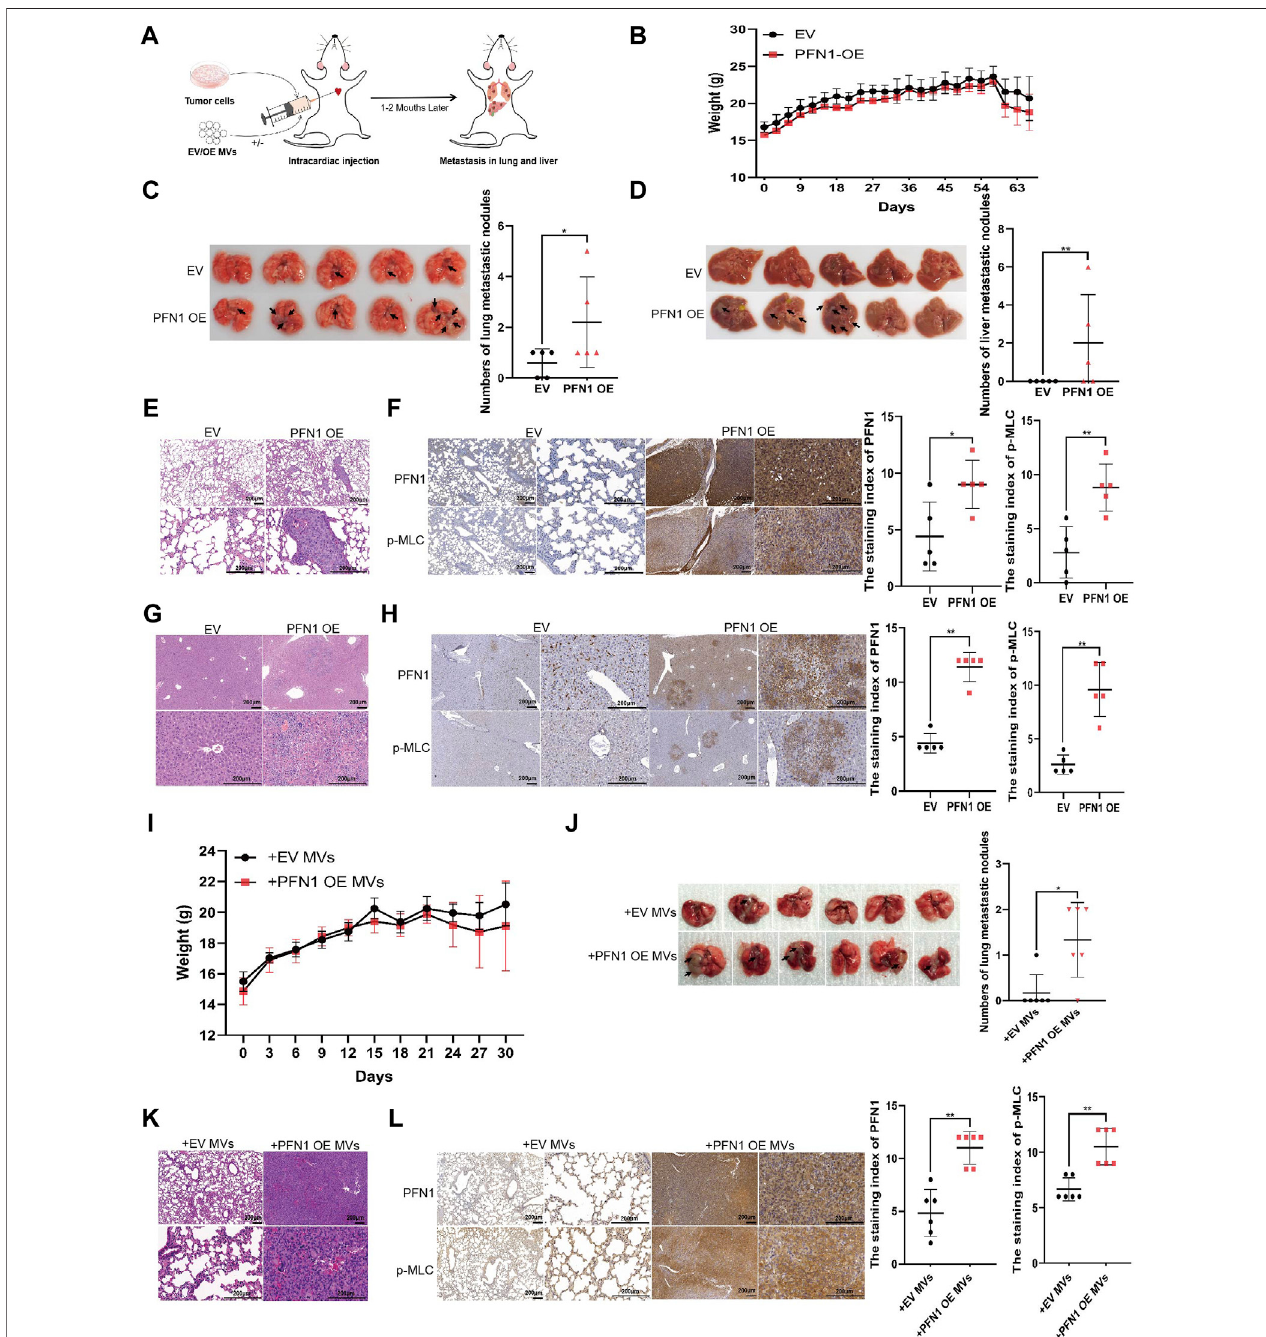
FIGURE4| PFN1promotes invivo NSCLCmetastasis byelevatingMVsecretion. (A) Schematicillustration ofthemousemodelofmetastatictumor established to determinetheroleofPFN1intumor metastasis. (B) Bodyweight changesinmiceafter intracardiac injection of PFN1 -overexpressing andEV-expressingcelllines. (C,D) Representative images of lung (C) and liver (D) metastases of the mouse model. The number of metastases is displayed in the right-hand side graph. * p < 0.05, ** p < 0.01. (E) RepresentativeimagesofHE-stainedlungtissuesofthemousemodel. (F) RepresentativeIHCimagesofPFN1andp-MLCexpressioninlungtissues.The staining index is shown in the right-hand side graph. ** p < 0.01. (G) Representative images of HE-stained liver tissues of the mouse model. (H) Representative IHC images of PFN1 and p-MLC expression in liver tissues. The staining index is shown in the right-hand side graph. ** p < 0.01. (I) Body weight changes in mice after intracardiac injection of H1299 cells and MVs. (J) Representative images of lung metastases of the mouse model. The number of metastases is shown in the bottom graph. * p < 0.05. (K) Representative images of HE-stained lung tissues of the mouse model. (L) Representative IHC images of PFN1 and p-MLC expression in lung tissues. The staining index is shown in the right-hand side graph; * p <